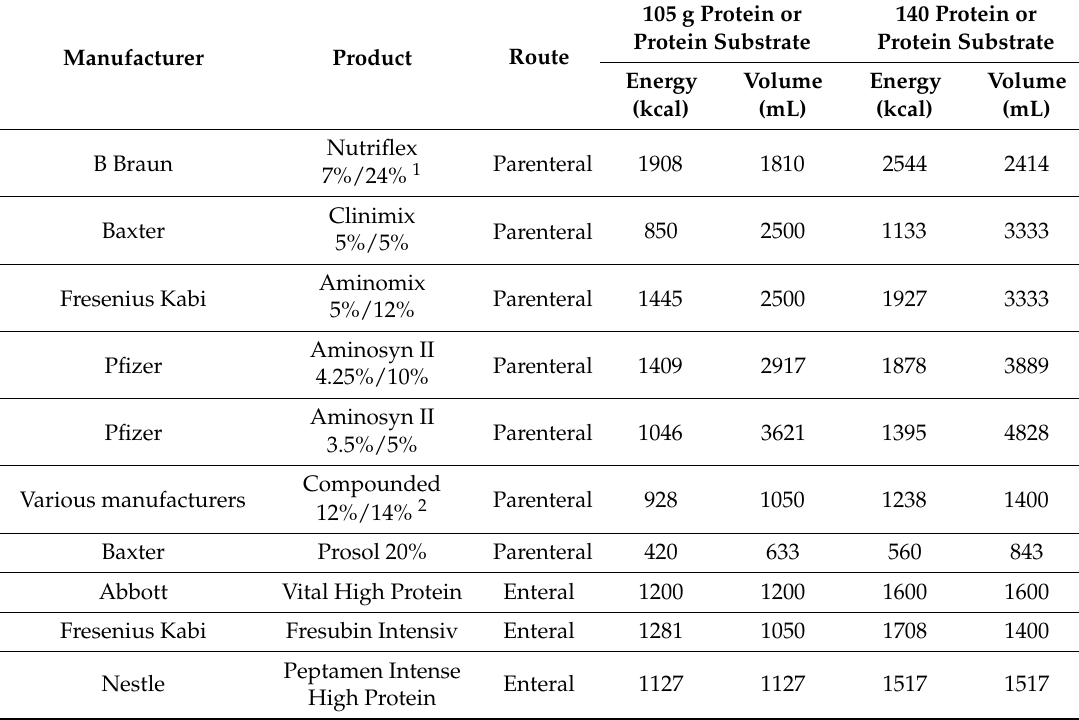
Table 2. Energy and Volume Delivered to Provide Protein or Protein Substrate to a 70 kg